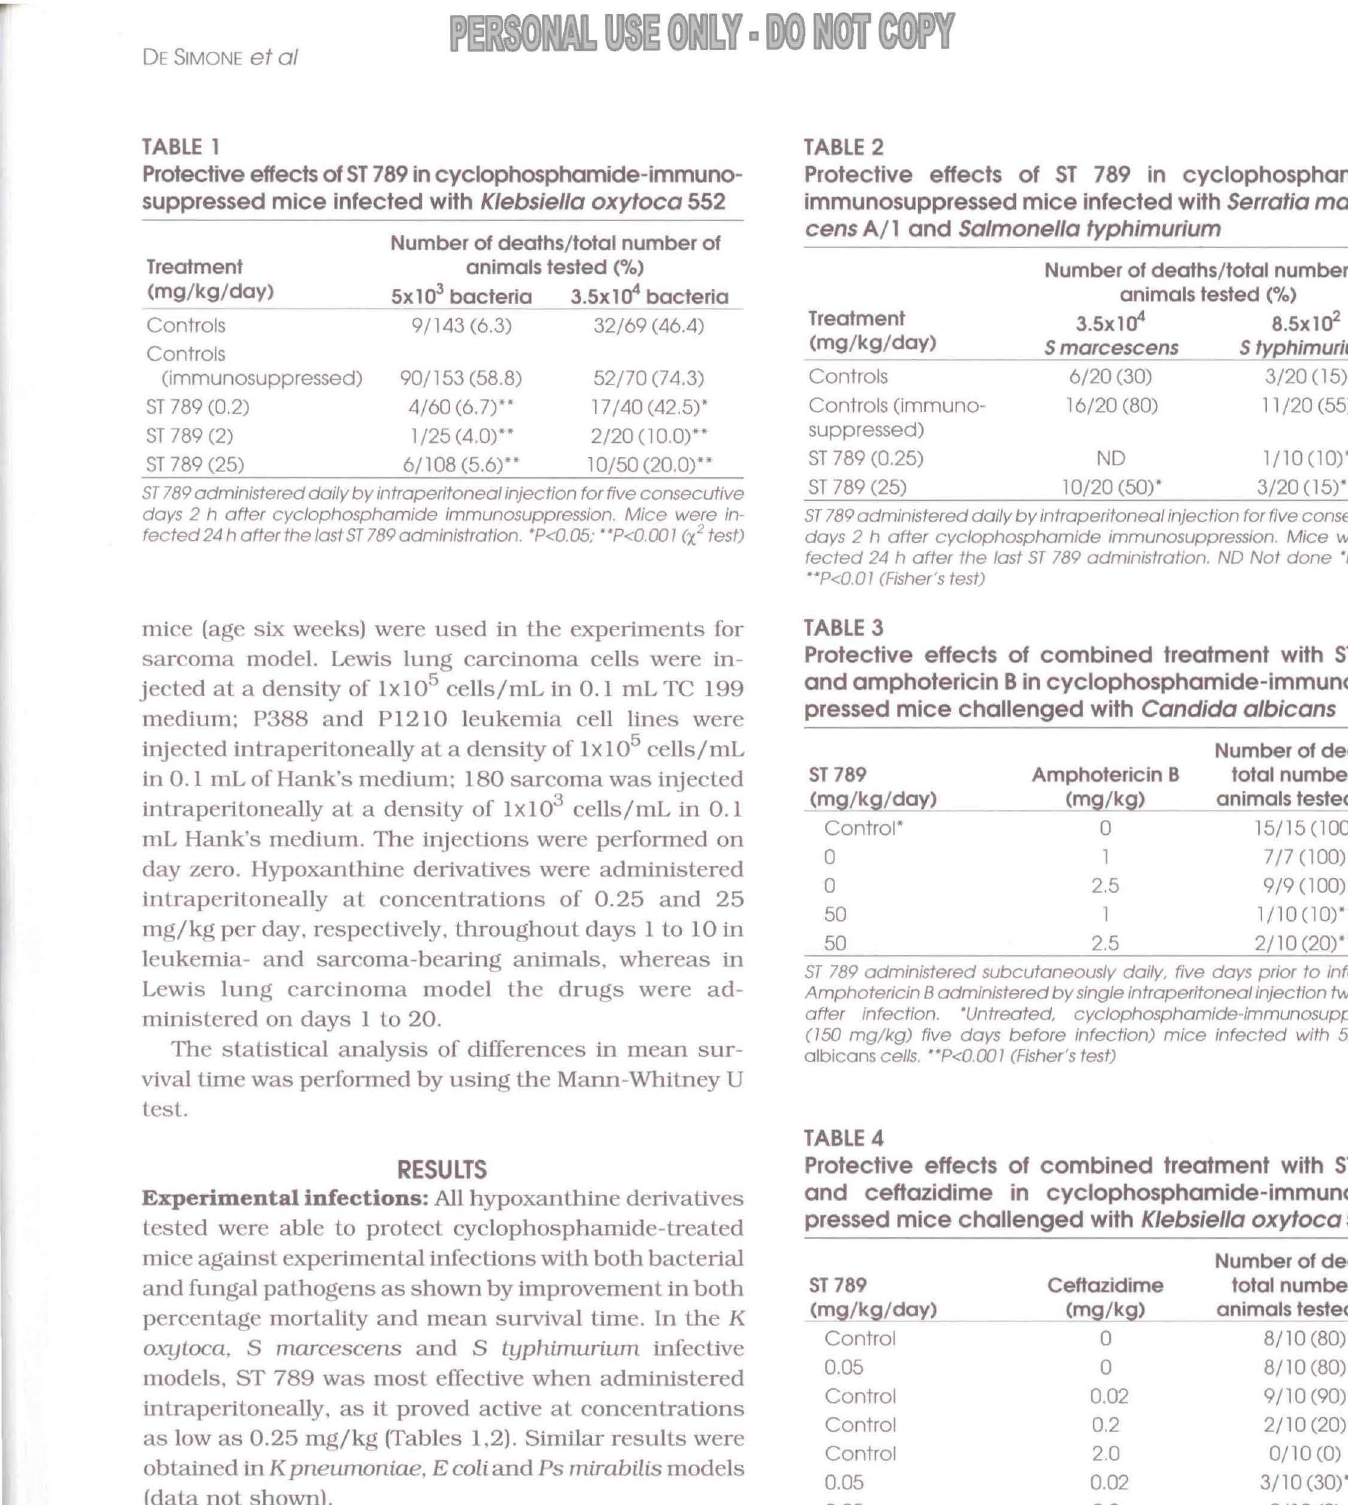
Protective effects of combined treatment with ST 789 and ceftazidime in cyclophosphamide-immunosup pressed mice challenged with Klebsiella oxytoca